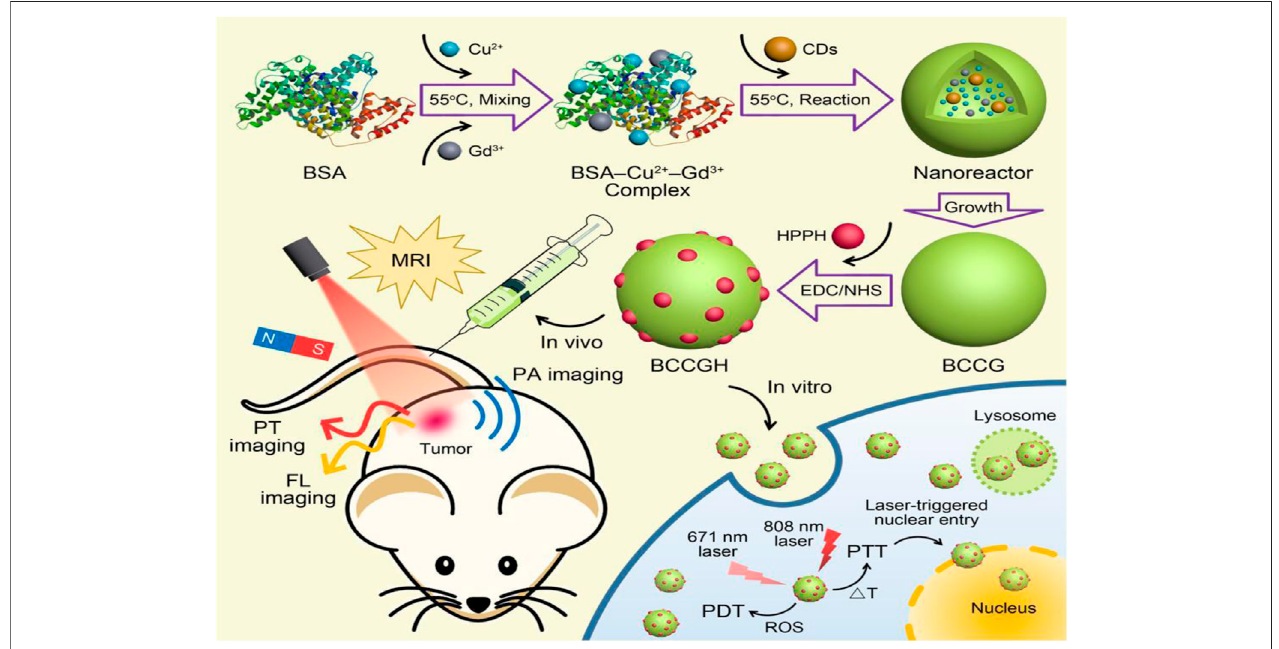
FIGURE 9 | Depiction of CD-DOX conjugate: Amine group of DOX binds with carboxylic group of CD, CD – DOX conjugates deliver to HepG2 cancer cells and HL- 7702 normal cells. The CD – DOXconjugates will release DOX in HepG2 cancer cells, but not in HL-7702 normal liver cells, due toa difference inpH i.e., acancer cell has low pH(Zeng et al., 2016).